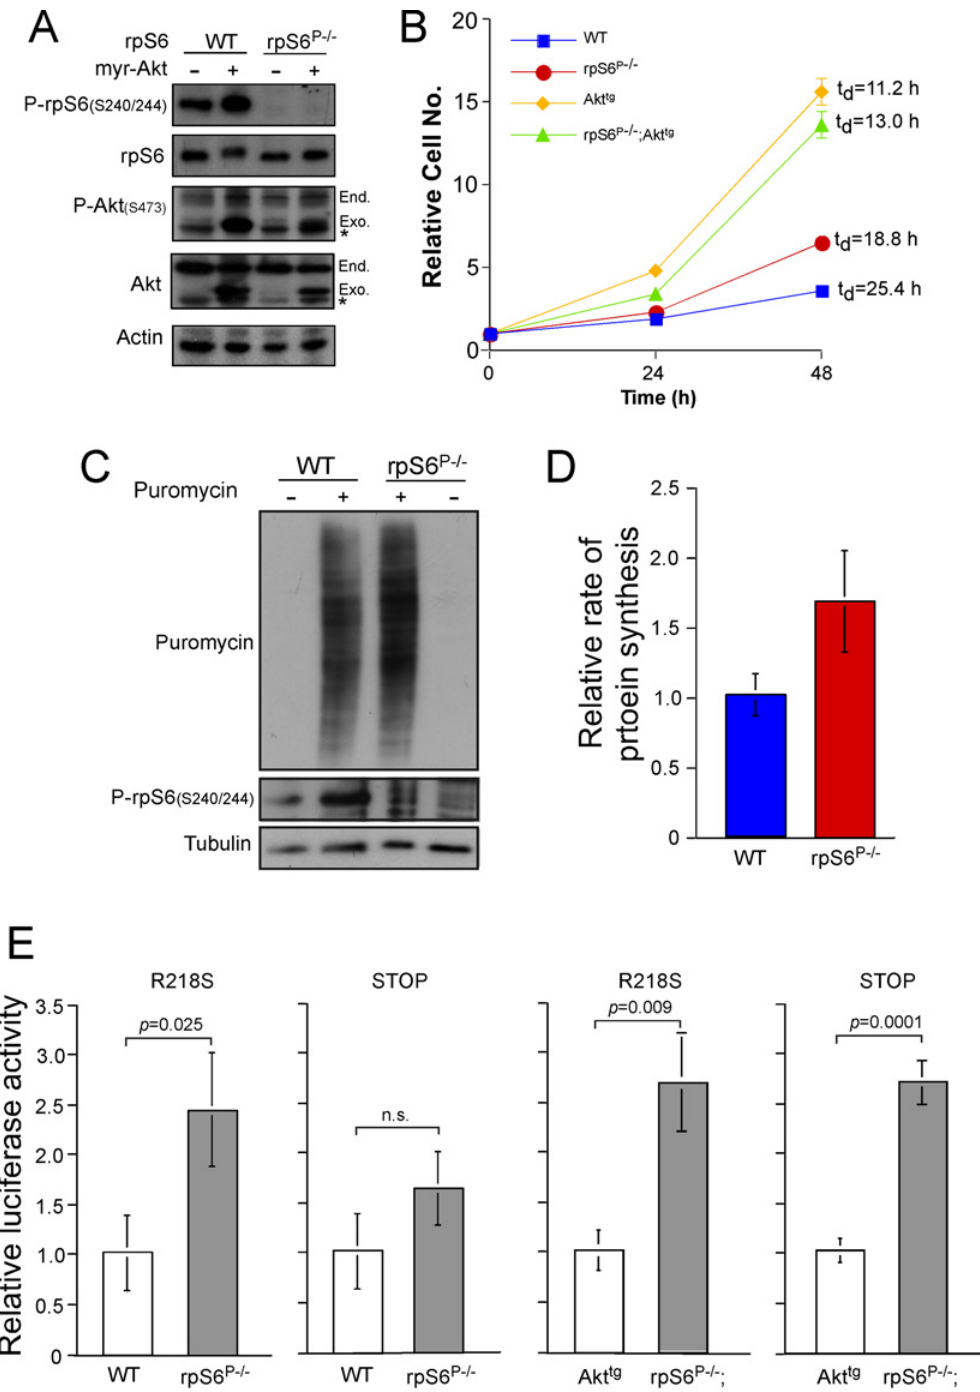
Fig 5. rpS6 phosphorylation deficiency increases proliferation and decreases translational fidelity in fibroblasts. (A) Immortalized WT, rpS6 P-/- , Akt tg and rpS6 P-/- ;Akt tg MEFs were harvested and their cytoplasmic proteins were subjected to Western blot analysis with the indicated antibodies. (B) MEFs described in (A) were seeded in 96-well plates at a density of 4 x10 3 per well. The proliferation of MEFs described in (A) was monitored as described in (Fig 4B). t d , population doubling time. (C) WT and rpS6 P-/- immortalized MEFs were incubated for 1 h with 1 mM puromycin, harvested and their cytoplasmic proteins were subjected to Western blot analysis with the indicated antibodies. (D) Quantification of signals obtained in 6 experiments similar to that described in (C). (E) WT, rpS6 P-/- , Akt tg , and rpS6 P-/- ;Akt tg MEFs were cotransfected with Renilla luciferase expression vector and any one of the following firefly luciferase expression vectors: Fluc(WT), Fluc(Stop) and Fluc(R218S). The transfection efficiency of any of the Fluc constructs was normalized to that